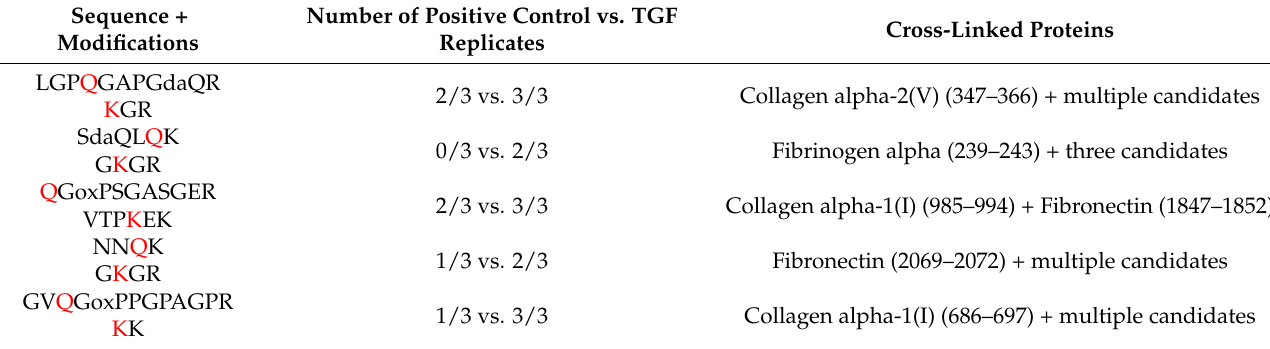
Figure 4. MS2 fragmentation spectra of the cross-linked peptides identified in the ECM of dermal fibroblast cultures treated with TGF β -1 for 30 days. Cross-links between LGPQGAPGdaQR and KGR ( a ) SdaQLQK and GKGR ( b ) QGoxPSGASGER and VTPKEK ( c ) NNQK and GKGR ( d ) and GVQGoxPPGPAGPR and KK ( e ) were found. Cross-linked glutamine (Q) and lysine (K) residues identified by MassMatrix are shown in red text. Hydroxyproline and deamidated glutamine residues are labelled as oxP and daQ, respectively. Table 1. Cross-linked peptides identified in the ECM of dermal fibroblast cultures treated with TGF β -1 for 30 days. Cross-linked glutamine (Q) and lysine (K) residues identified by MassMatrix are shown in red text. Hydroxyproline and deamidated glutamine residues are labelled as oxP and daQ, respectively. Alongside the peptide sequences, the number of replicates in which the peptides were found and the corresponding proteins are also given. The sequence number ranges are given in brackets after each parent